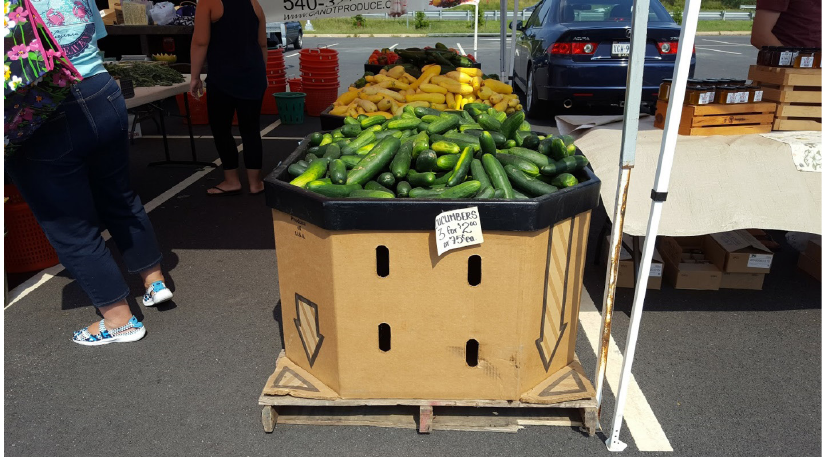
Figure 3. Strategy for displaying produce at the Spotsylvania County Farmers Market, 2016. Photo by author.